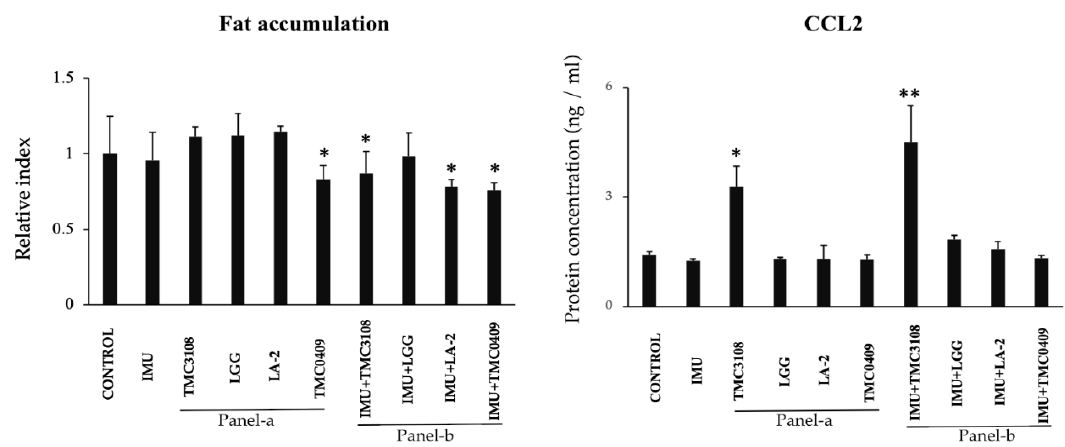
Figure 11. Immunobiotic mediated regulation of fat accumulation and inflammatory responses in an immune cell-adipocyte co-culture model. A total of 1 × 10 6 immune cells / well of a 6-well plate were cultured on adipocytes 4-days di ff erentiated. Bacterial samples (5 × 10 8 cells / well) were also added and cultured for 2 or 4 days. Adipocyte cells were stained with Oil red O stained and fat accumulation in the adipocytes was quantitatively analyzed by image J software. The ELISA-based concentration of CCL2 protein in supernatant of adipocyte-culture stimulated by immune cells and lactic acid bacteria (LAB). All data shown are the mean ± SD of three independent experiments performed in triplicate. The asterisks: ‘*’ and ‘**’ indicated statistical di ff erences either between bars of panel-a and control or between bars of panel-b and IMU, with significant levels of p < 0.05 and p < 0.01, respectively. Control, untreated adipocytes; IMU, cell free supernatant (CFS) medium obtained from immunocompetent cell (antigen presenting cell) culture; Panel-a, adipocytes directly exposed to LAB; Panel-b, adipocytes exposed to CFS obtained from di ff erent LAB treated immunocompetent cells; TMC3108, Bifidobacterium bifidum TMC3108; LGG, Lactobacillus rhamnosus GG; LA-2, Lactobacillus